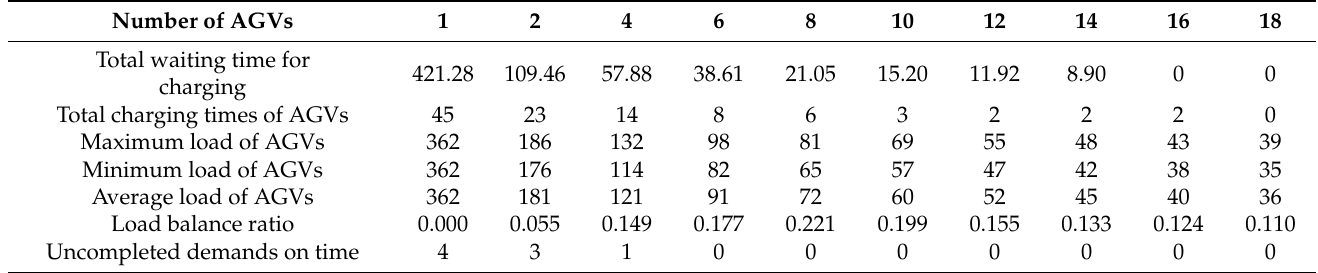
Table 5. AGV load and